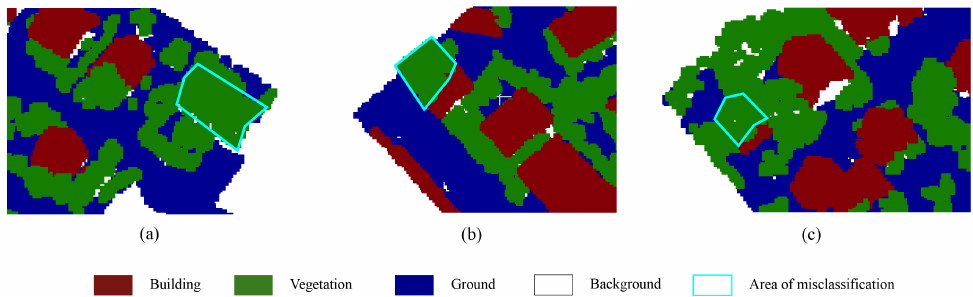
Figure 8. Classification results of the Vaihingen sites.